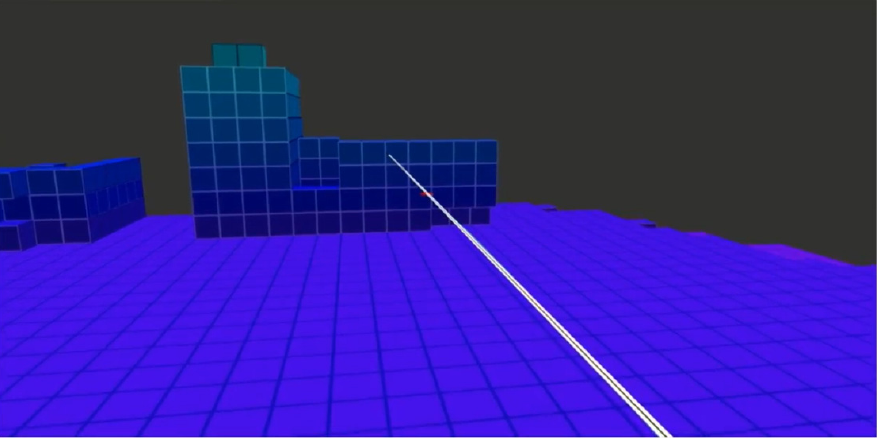
Figure 16. Image showing the environment representation based on the LIDAR measurements under the ROS environment.